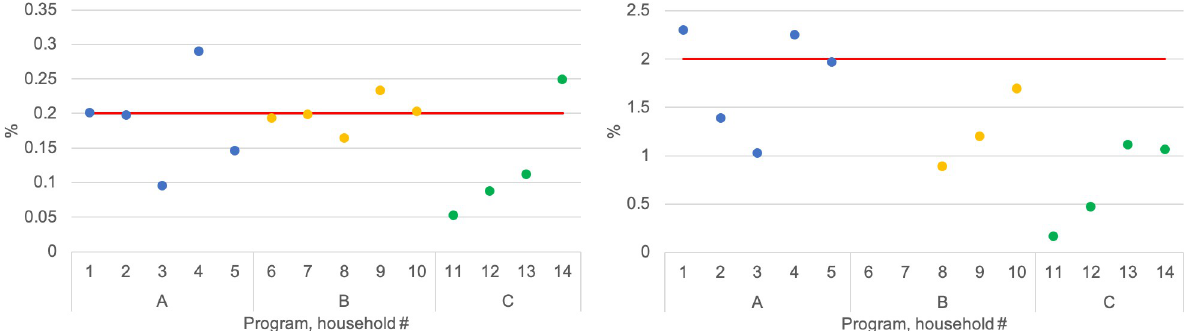
Fig 1. Measured chlorine concentrations (%) in spraying solutions by Program and household (#1 to #14); red line denotes target concentrations of 0.2% (left) and 2.0% (right).